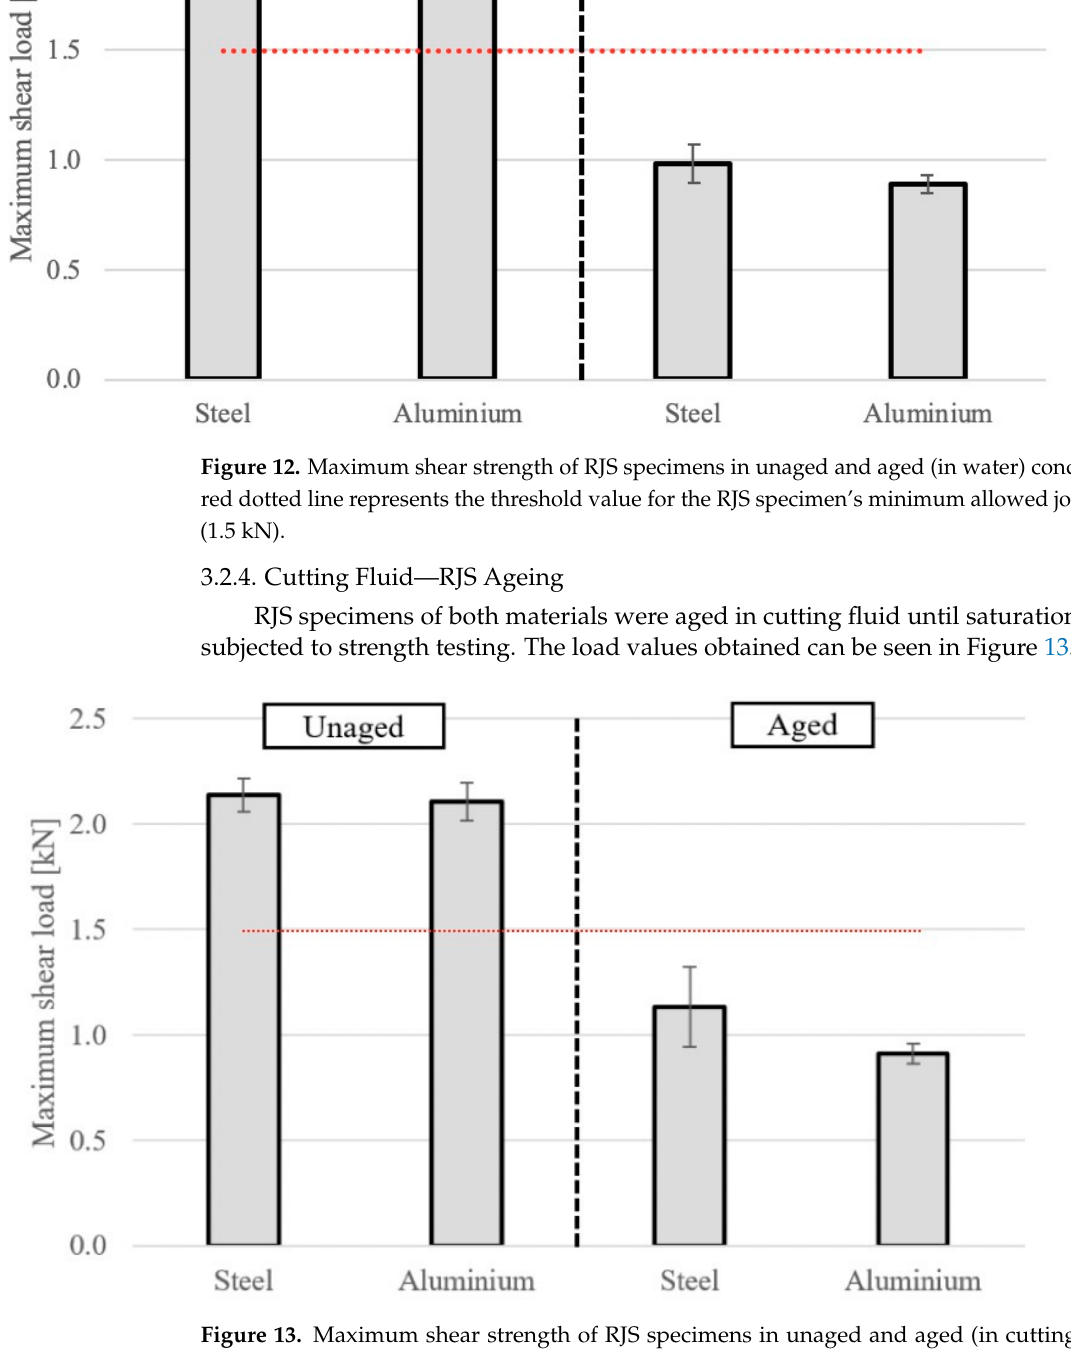
Figure 13. Maximum shear strength of RJS specimens in unaged and aged (in cu tt ing emulsion) conditions. The red do tt ed line represents the threshold value for the RJS specimen’s minimum al- lowed joint strength (1.5 kN).